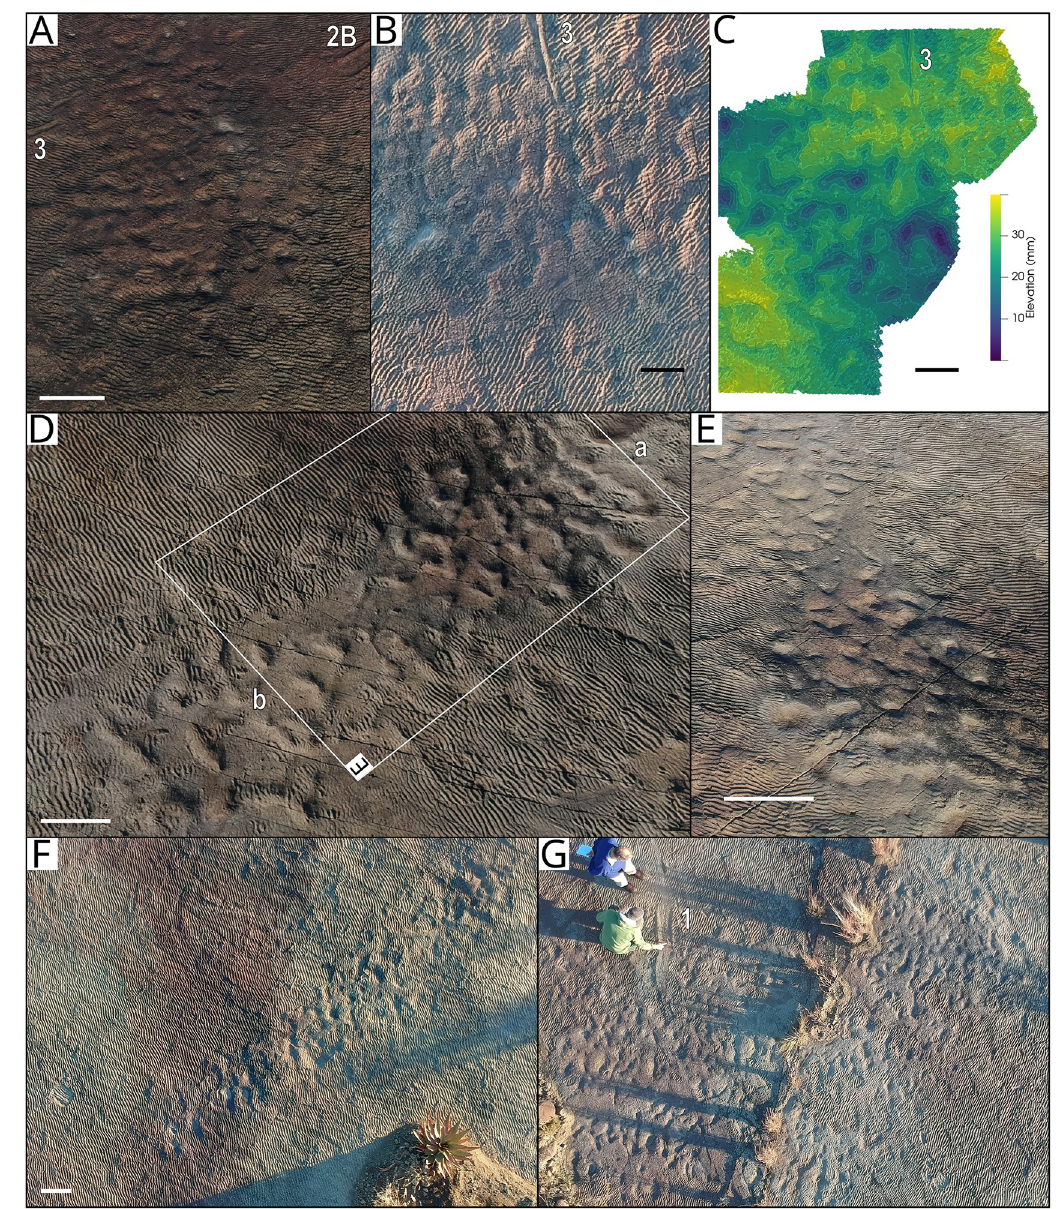
Fig 8. Groupings of subcircular depressions interpreted as footprints on the Dave Green palaeosurface. A) Aerial oblique photograph of the western portion of the “corridor” of footprints between Impression 2 and 3. B) Overhead photograph of the ‘corridor’ between Impressions 2 and 3 with the false-colour depth model (C). D) Overhead view of the eastern portion of the ‘corridor’ with an oblique view of the footprints between points ‘a’ and ‘b’ (E). F) Overhead view of the concentration of depressions just north of the present-day ‘island’. G) Overhead view of the depressions in the northwestern part of the surface. Large impressions are numbered in A-C and G. Scale bars equal 30 cm (A, D-F) and 50 cm (B and